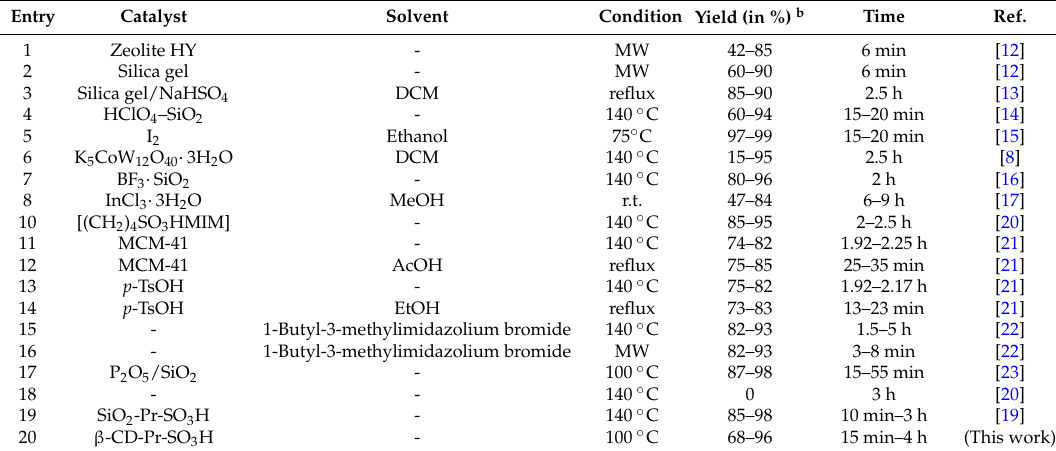
Table 2. The comparison of efficiency of various catalysts for the synthesis of 1,2,4,5-tetrasubstituted imidazoles a .